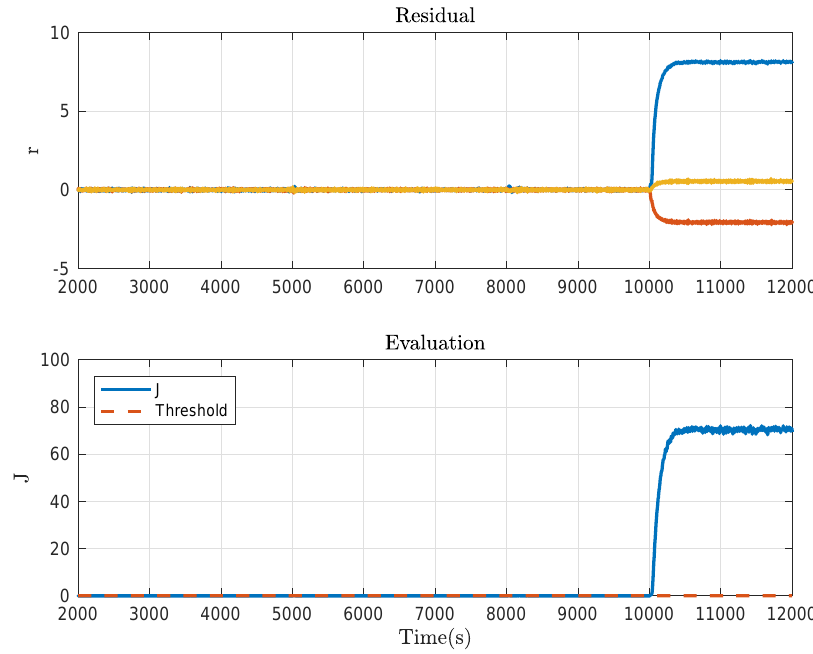
Figure 8. Fault detection result under the plugging